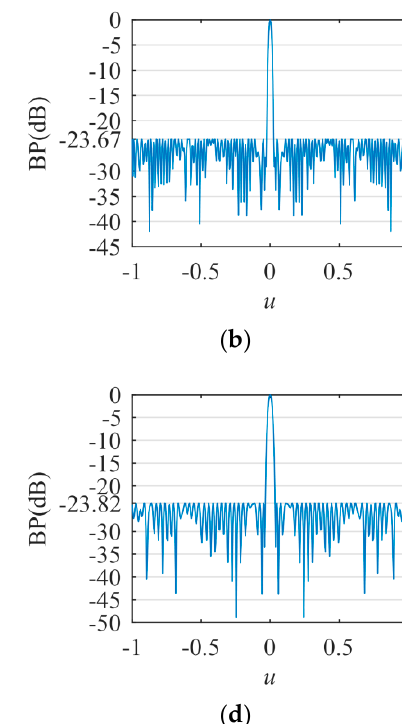
Figure 9. Positions and weight values of active sensors.